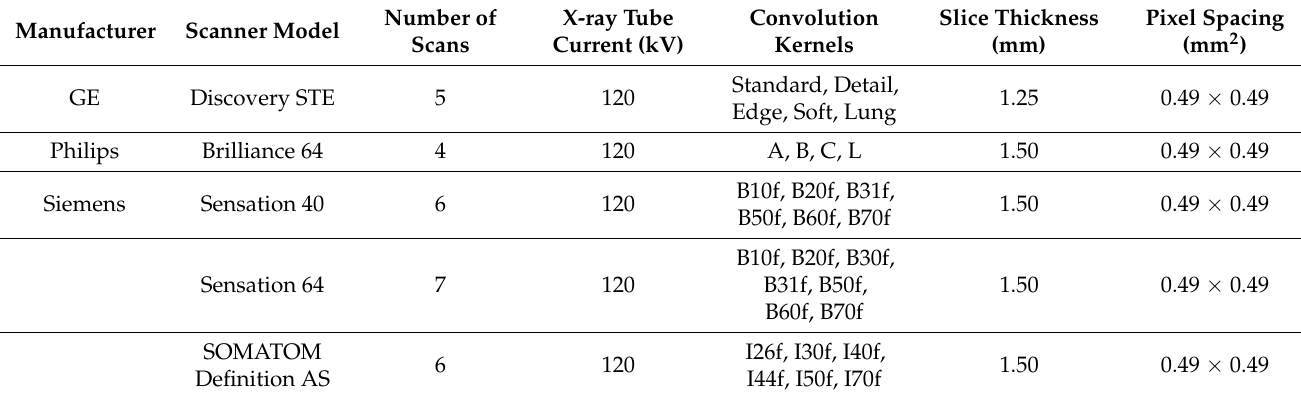
Table 1. Acquisition and reconstruction parameters for the imaging